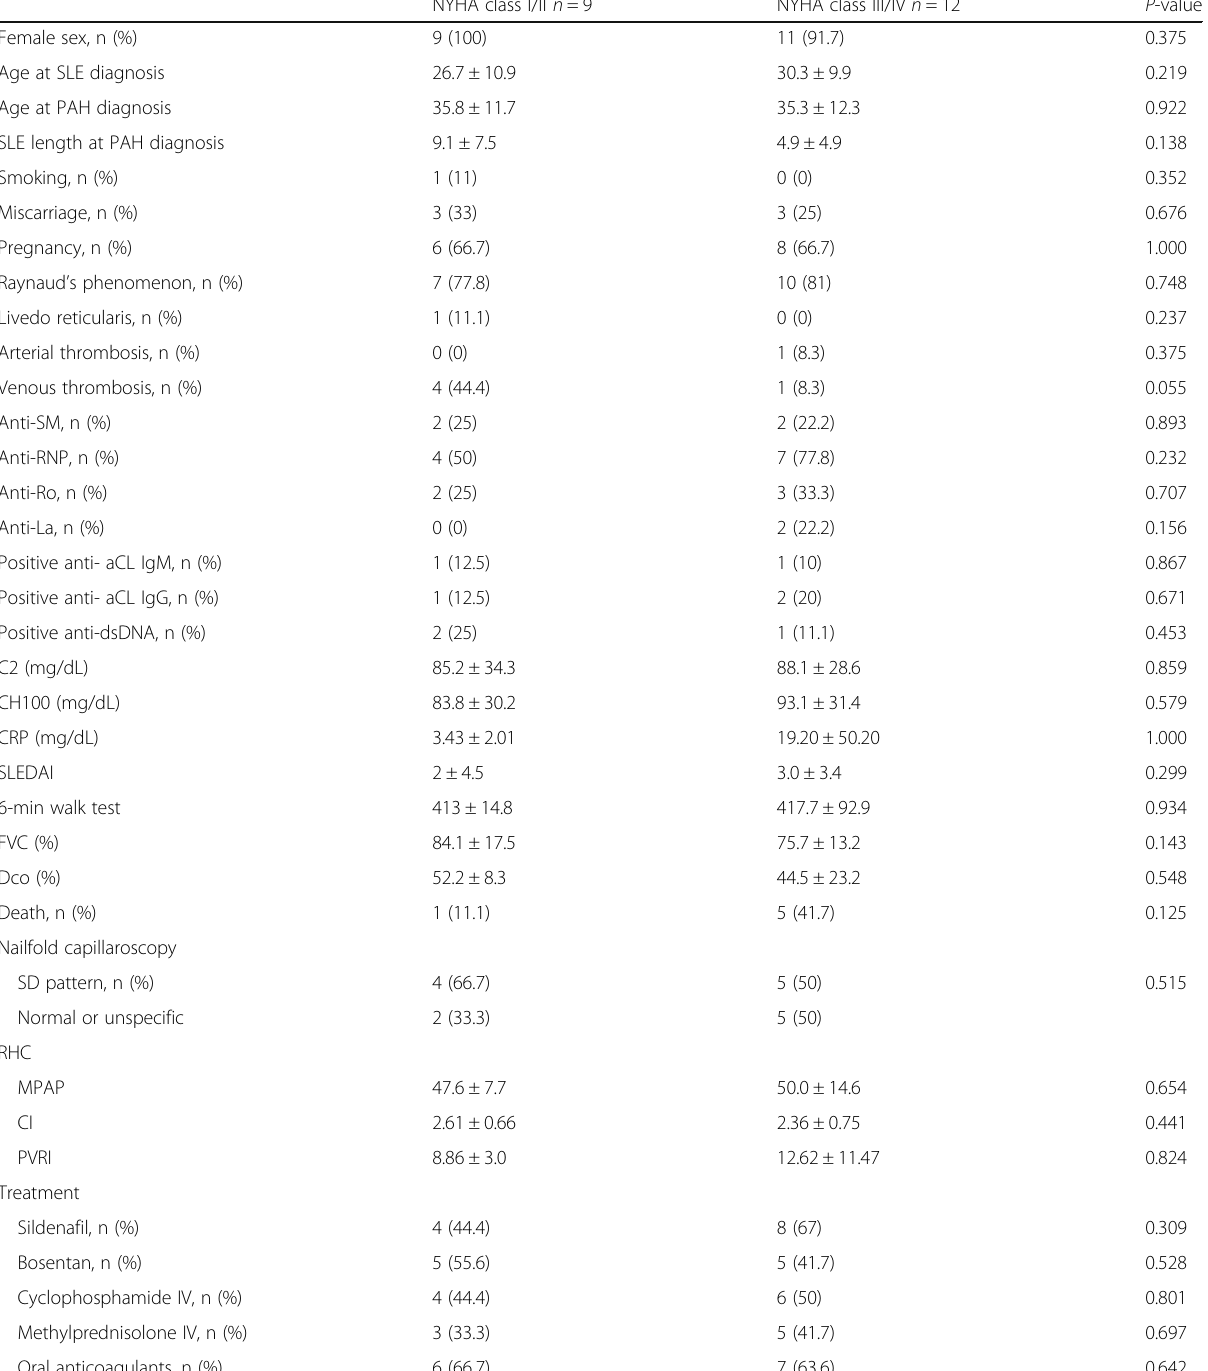
Table 5 Demographic and clinical characteristics of patients with SLE and PAH by NYHA functional classes I/II and